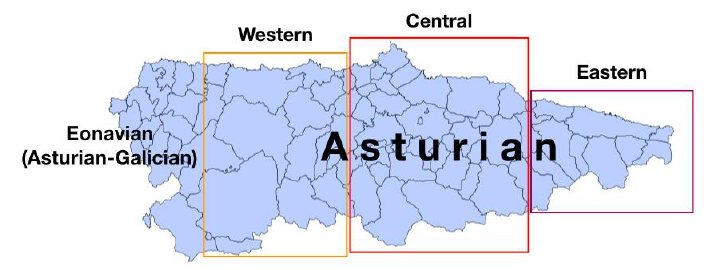
Figure 1. Main dialectological domains of